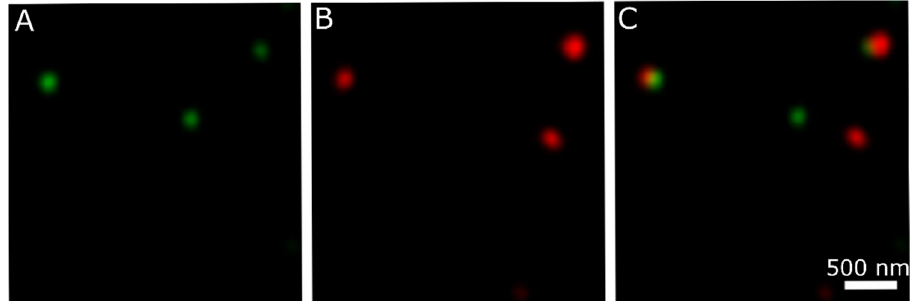
Figure 7. Fluorescence analysis of hybrid nanotube 041 Δ 200GFPmCherry. ( A ) Recorded GFP fluorescence signal; ( B ) recorded mCherry signal; ( C ) overlay of ( A ) and ( B ).